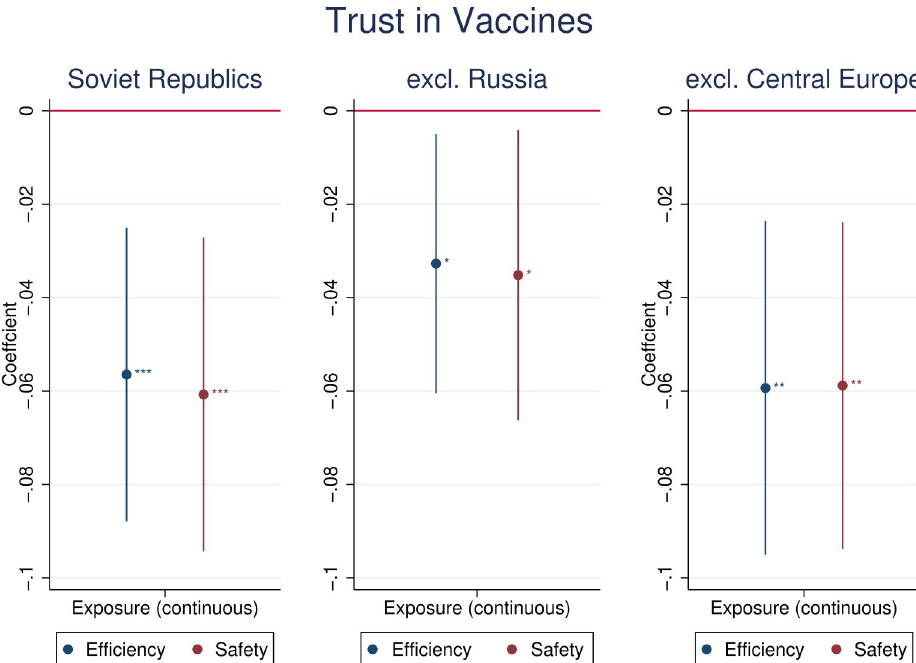
Fig 5. Robustness of the main results to country groups exposed to Soviet communism. Notes : Soviet Republics: Armenia, Azerbaijan, Belarus, Estonia, Georgia, Kazakhstan, Kirghistan, Latvia, Lithuania, Moldova, Russia, Tajikistan, Turkmenistan, Ukraine, Uzbekistan. Central Europe: Belarus, Czech. Republic, Estonia, Georgia, Hungary, Latvia, Lithuania, Poland, Romania, Slovakia, Ukraine. The treatment variable is the length of exposure to Soviet communism in years smoothed with inverse hyperbolic sine function. Control variables: age fixed-effects, gender, country fixed-effects and country-specific time trend. Presented confidence intervals at 95% significance level are obtained using standard errors clustered by country. Statistical significance: � — p < 0.10, �� − p < 0.05, ��� − p < 0.01. Source : WGM